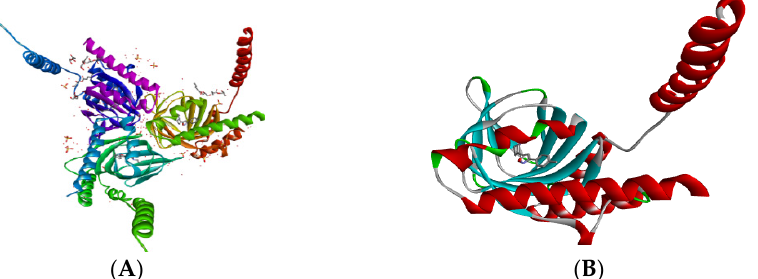
Figure 2. Schematic structure of the ( A ) X-ray crystallographic structure of σ 1R co-crystallized with PD14418 (PDB:5HK1) ( B ) Discovery Studio prepared 5HK1. Docking yielded the most stable conformer free-binding energy scores (i.e., binding affinities in kcal/mol) and H-bonding interactions within the active site of σ 1R (Table 3). Additionally, docking revealed relevant amino acids for bonding interactions in the active site of σ 1R (5HK1). Example interactions are illustrated in Figure